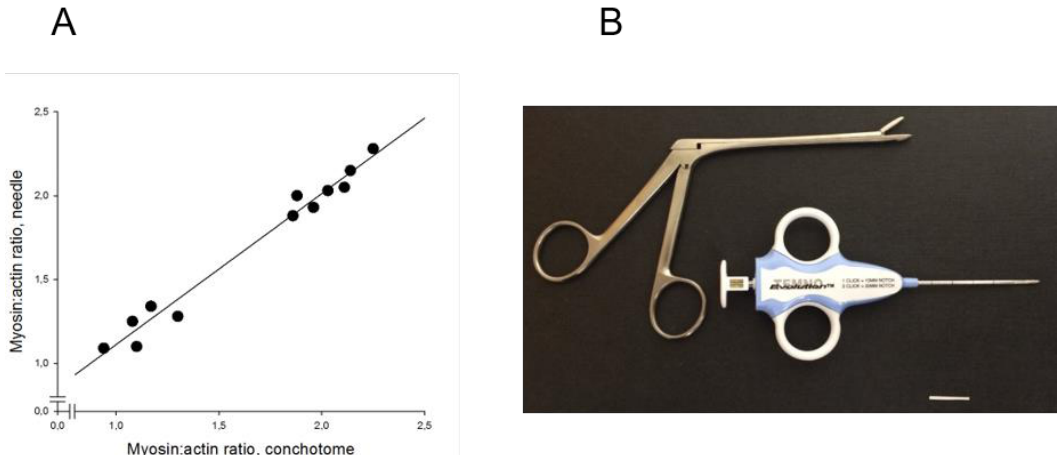
Figure 3. ( A ) M:A ratios determined in 12 intensive care unit (ICU) patients with varying myosin:actin ratios. Ratios compared between samples obtained with the soft-tissue semi-automatic needle and the conchotome instrument (R 2 = 0.98, p < 0.001); ( B ) soft-tissue semi-automatic needle and the conchotome instrument. The horizontal bar denotes 20 mm.